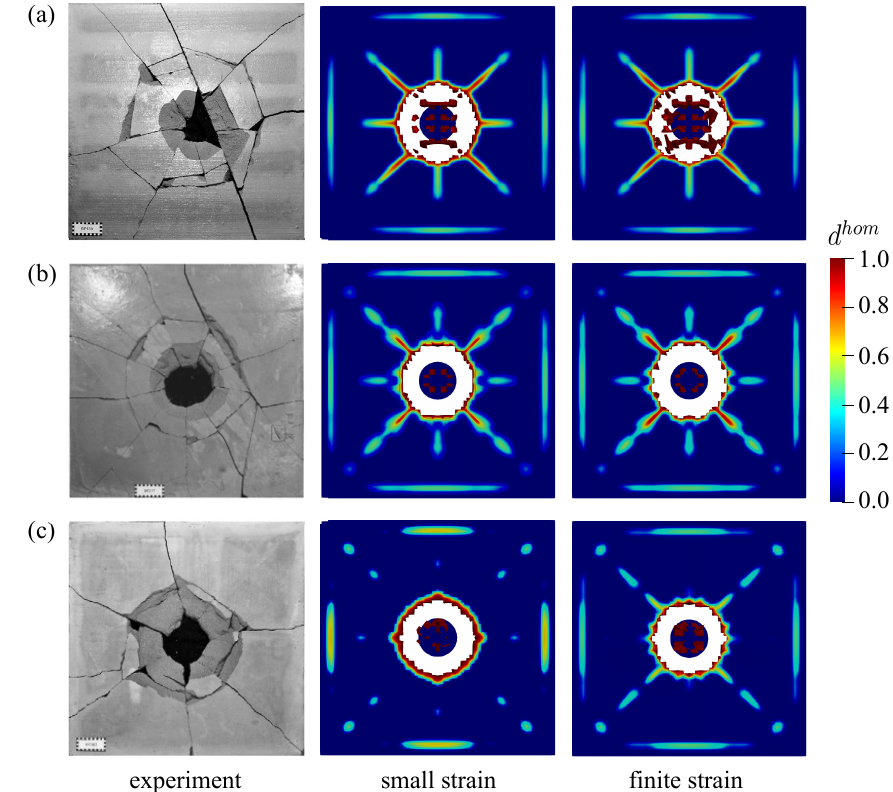
Figure 27. Bottom view of thin plate impact test for experiments in [48] comparing small and finite strain simulations at three different velocities: ( a ) 12.3 m/s, ( b ) 16.5 m/s, and ( c ) 20.3 m/s.